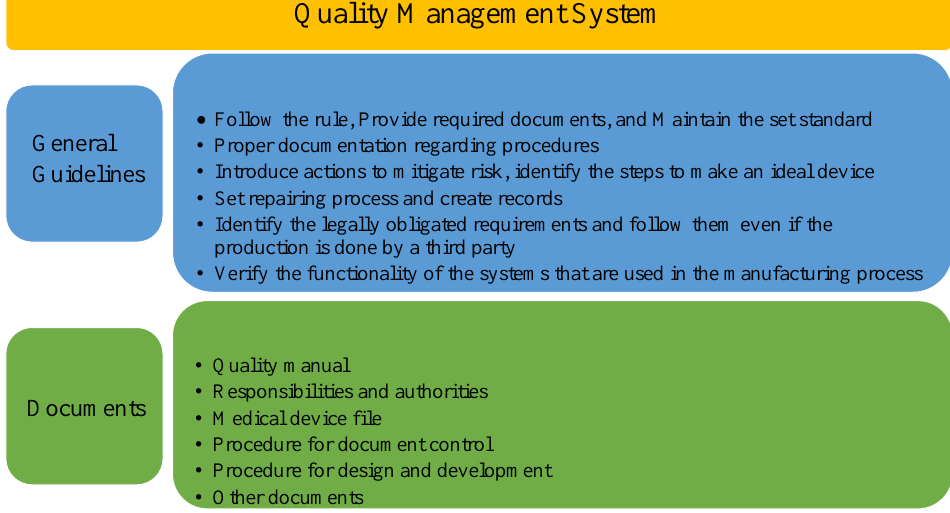
Figure 9. Quality management system of ISO